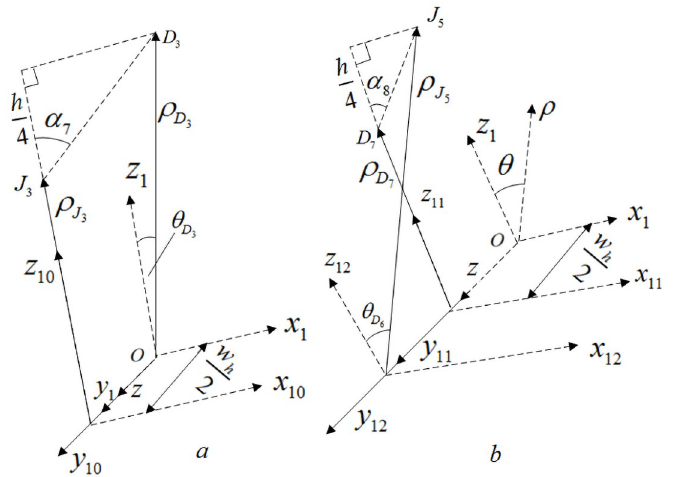
Fig 11. Calculation of braiding angle of internal cell